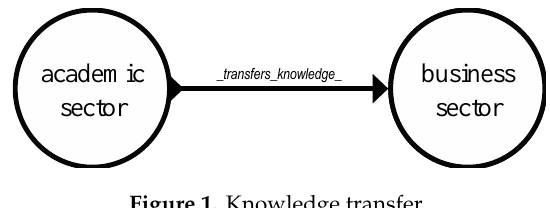
Figure 1. Knowledge transfer.